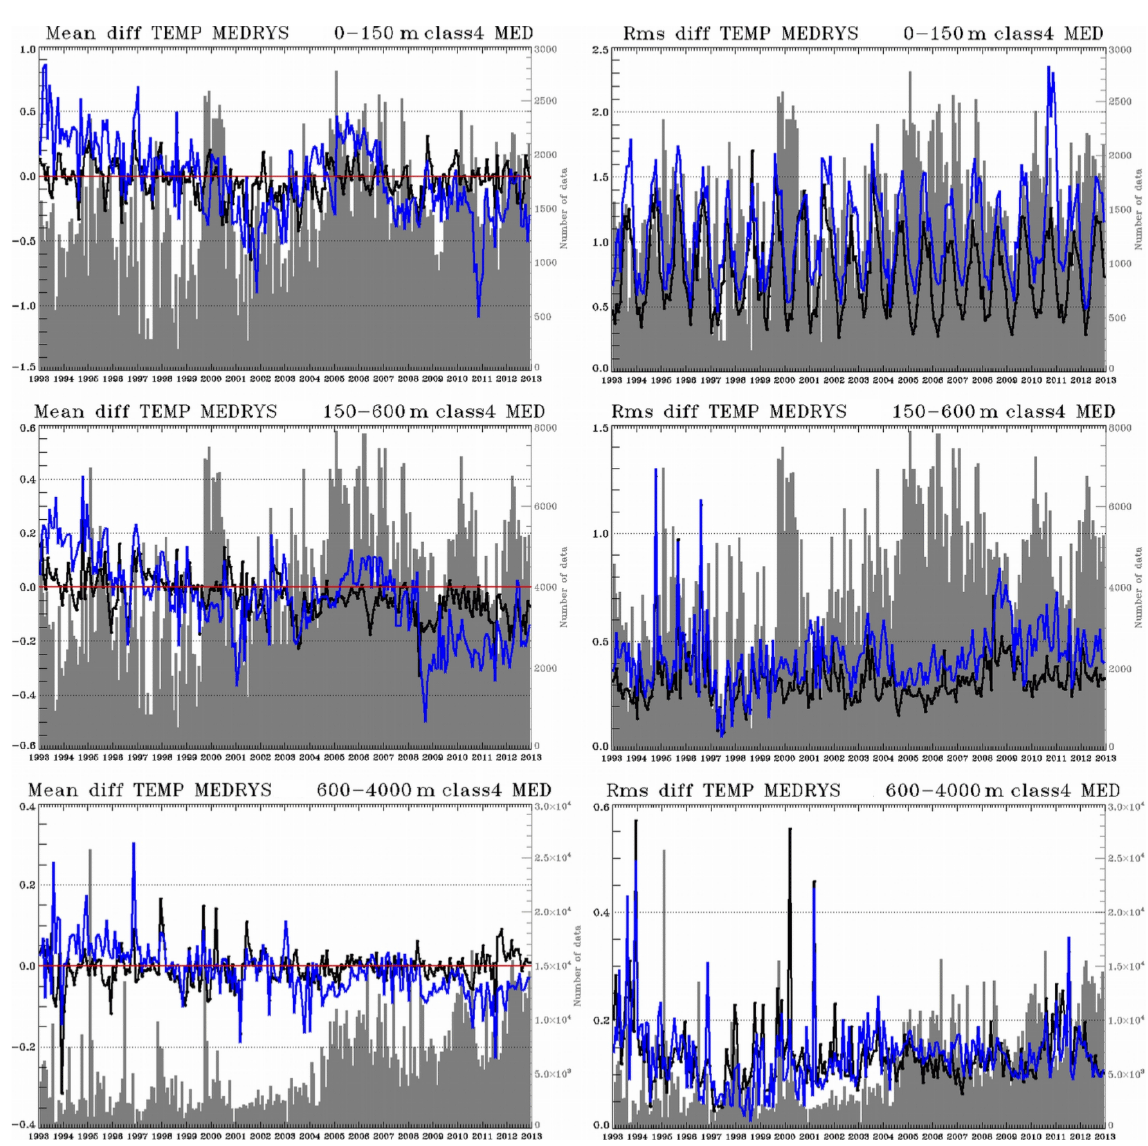
Figure 12. Temperature ( ◦ C) mean (upper row) and rms (bottom row) differences analysis minus observation (black), and MEDATLAS-1998 minus observation (blue). For these diagnostics, all available T/S observations from the CORIOLIS database and MEDRYS daily average analysis, collocated (temporally and spatially) with observations, are used. The number of observations is shown with gray bars. Averages are performed in the 0–150m (left), 150–600m (middle) and 600–4000m (right) layers in the whole Mediterranean